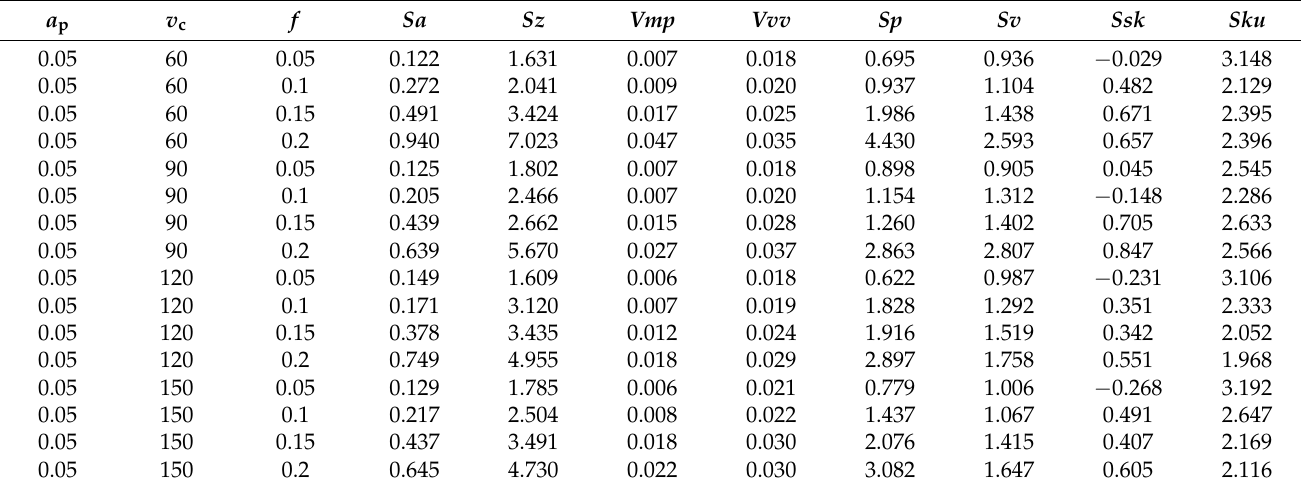
Table A1. Topography parameter data (hard turning, a p = 0.05 mm).